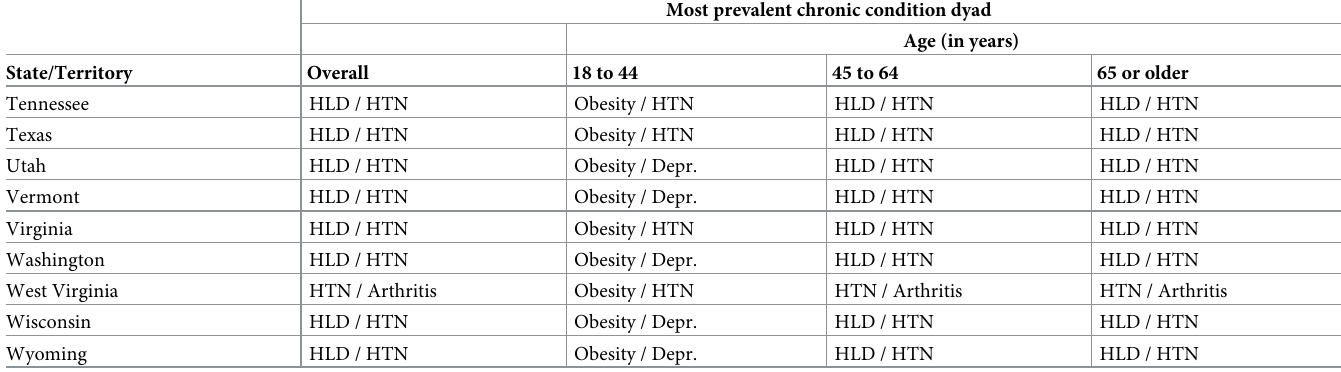
S1 Table. Prevalence of diagnosed multiple chronic conditions among adults aged � 18 years, by state or territory and by sex, age, and annual household income—Behavioral Risk Factor Surveillance System, United States,